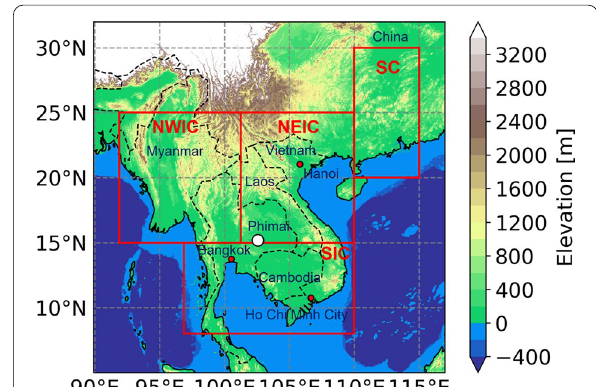
Fig. 1 Geographical locations of the SKYNET Phimai site and the four regions. The black open plot indicates the SKYNET Phimai site (15.18° N, 102.56° E, 212 m asl), and the red boxes indicate southern China (20° N–30° N, 110° E–115° E), northwest Indochina